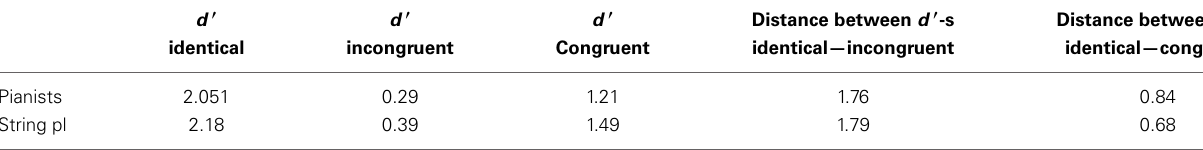
Table 3A | The distances between d (cid:2) -s based on the responses for stimuli with identical timbres and on the responses for stimuli with “incongruential” timbral order (penultimate column), and between d (cid:2) -s at identical and at “congruential” timbral orders (last column). The values of d (cid:2) and c are presented in the first three columns.